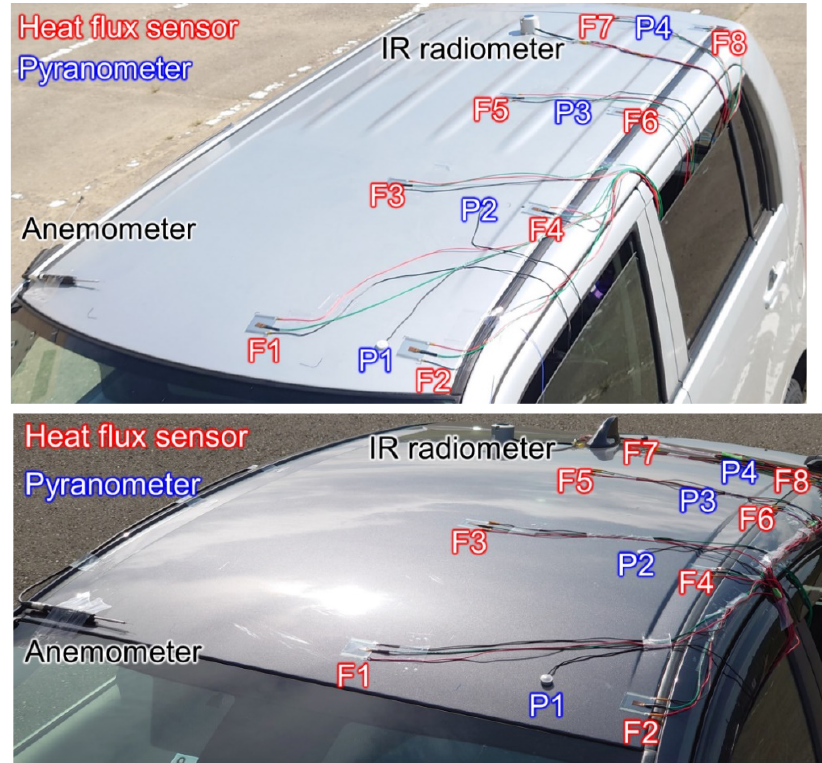
Figure 1. Shape of the experimental vehicle: small van ( top ), sedan ( bottom ).